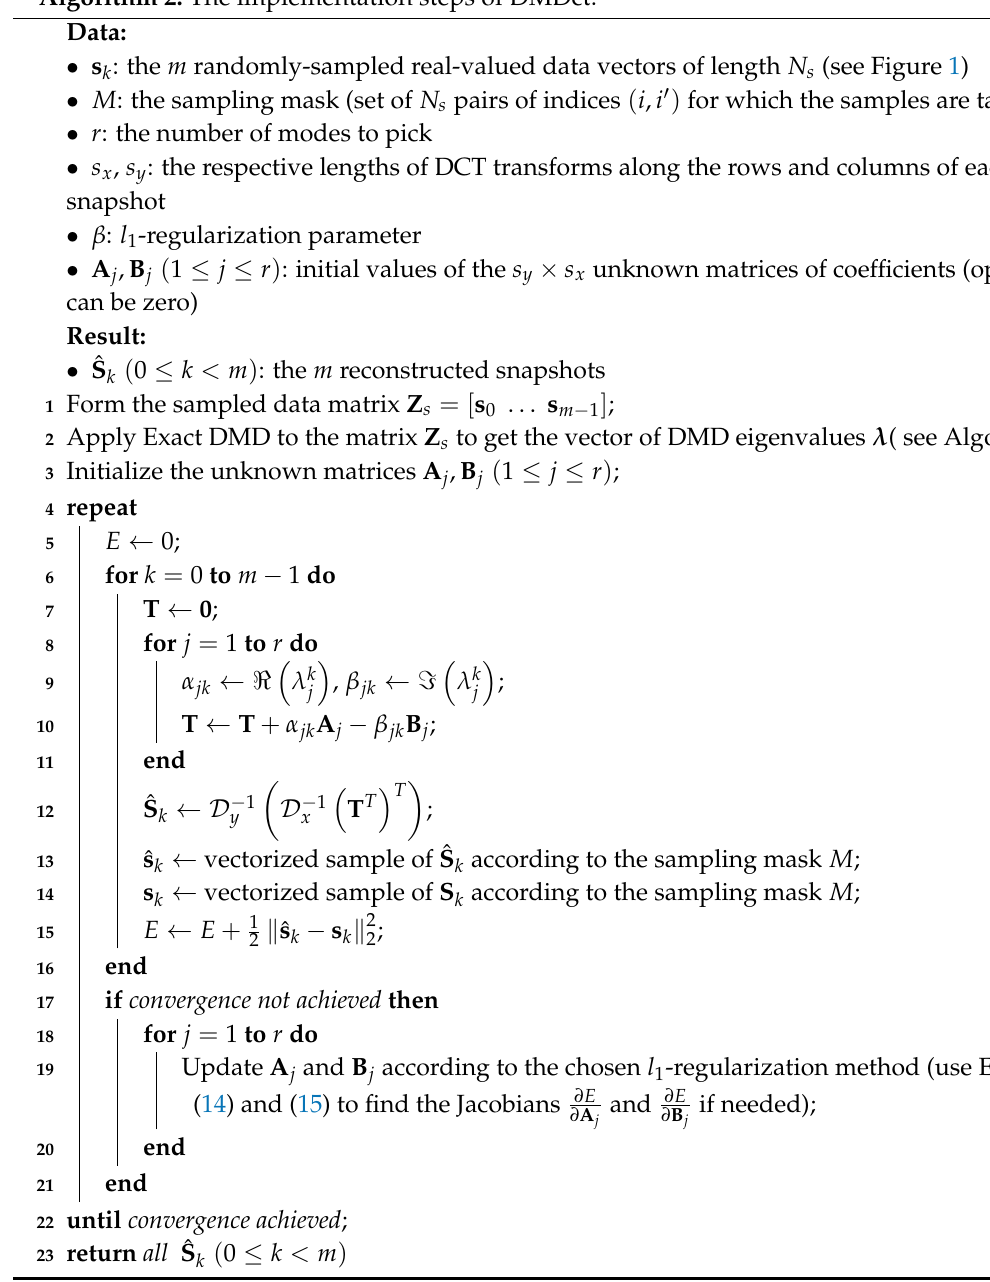
Algorithm 2. The implementation steps of